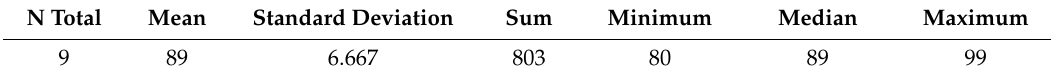
Figure 3. Distribution of snow melting days Table 1. Qinjia snowmelt dates statistical results.